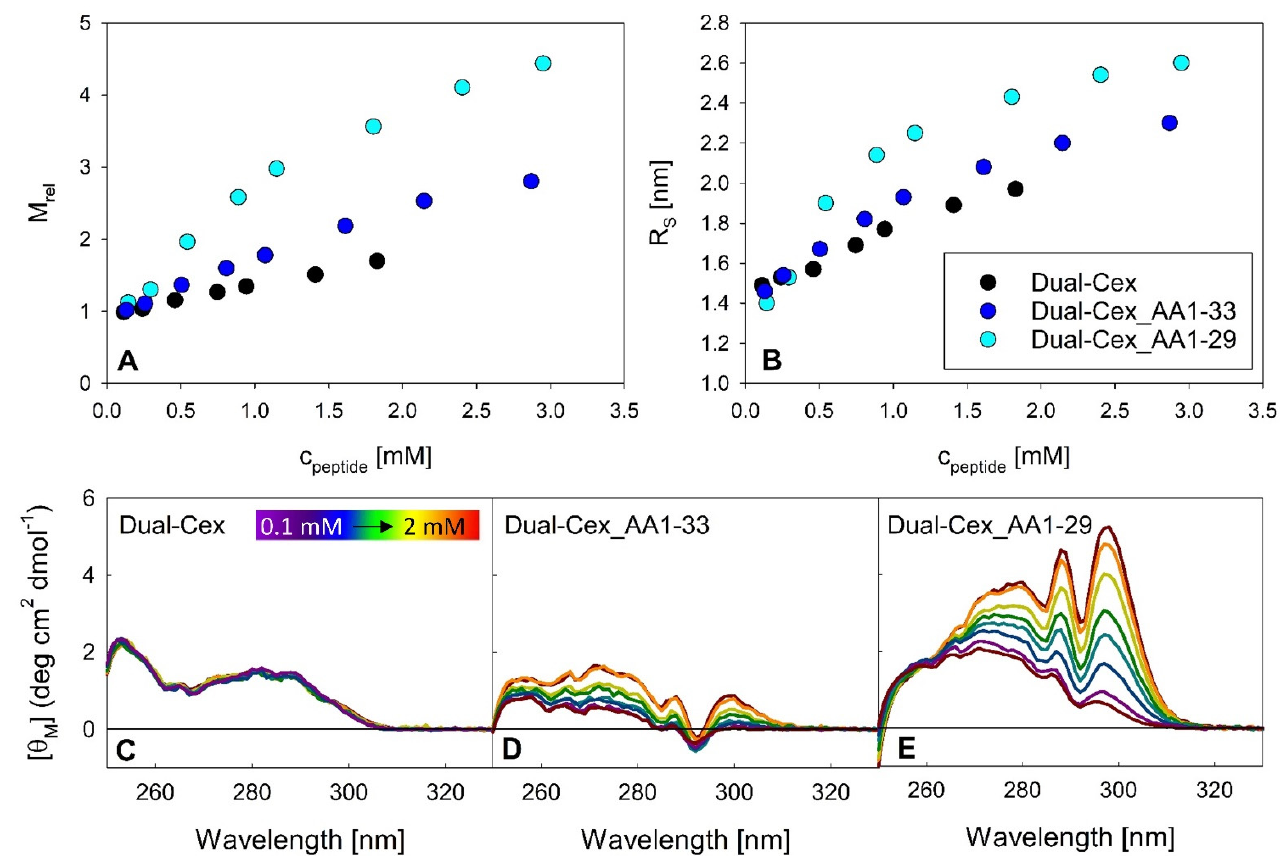
Figure 7. Structural consequences of C-terminal truncation of Dual-Cex. ( A , B ) show association equilibria in the context of relative molecular masses M rel ( A ) and Stokes radii R S ( B ) of Dual-Cex and two C-terminally truncated Dual-Cex variants measured at 23 °C. Near-UV CD spectra ( C – E ) were measured for a peptide concentration range from around 0.1–2 mM.